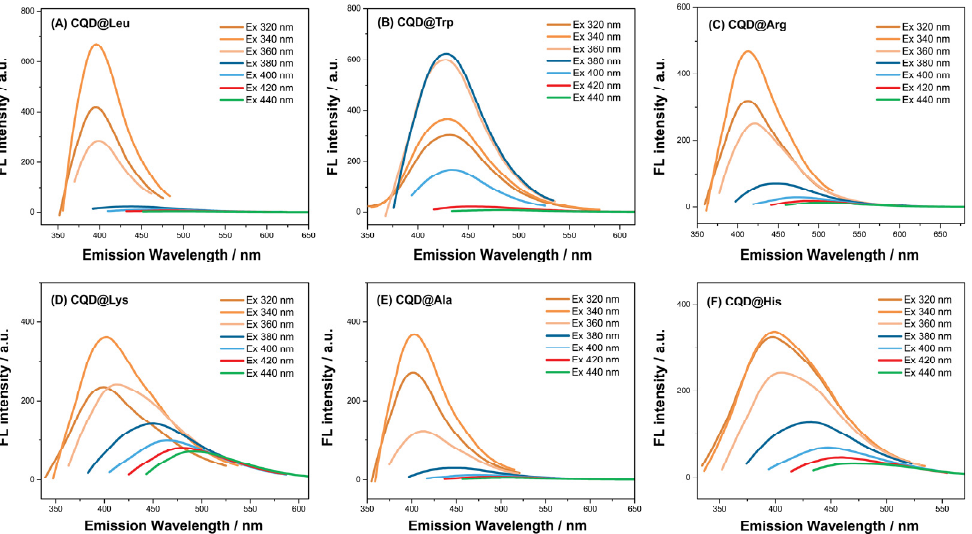
Figure 6. Fluorescence spectra of prepared CQDs: ( A ) CQD@Leu [80], ( B ) CQD@Trp, ( C ) CQD@Arg, ( D ) CQD@Lys, ( E ) CQD@Ala, ( F ) CQD@His recorded at different excitation wavelengths ranging from 320 nm to 440 nm (increments of 20 nm).